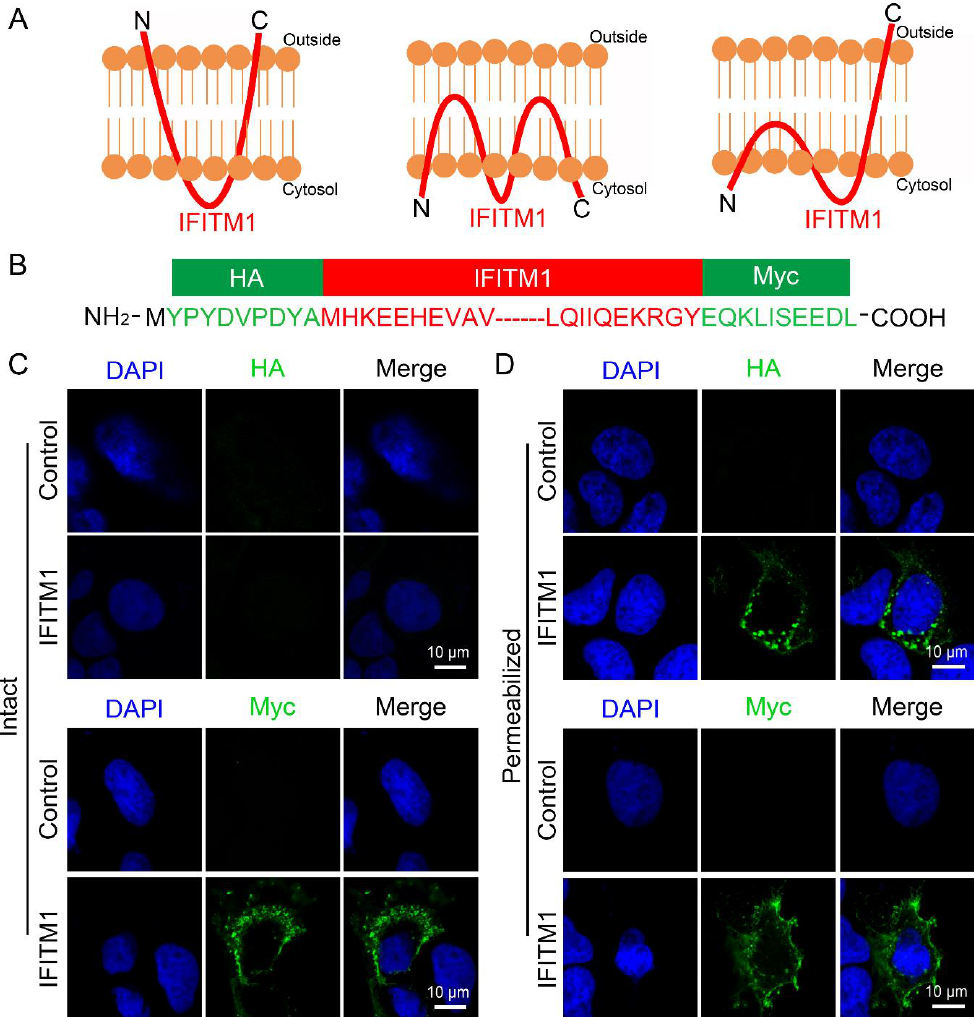
Figure 2. The topological structure analysis of IFITM1 on cell membranes. ( A ) Three different topological models of IFITM1 in cell membranes. IFITM1 was drawn using the red curve. N and C represented N-terminus and C-terminus, respectively. ( B ) Sketch of the amino acid sequence of HA-IFITM1-Myc. ( C , D ) The location of HA-IFITM1-Myc in Huh7 cells. pcDNA3.1 and pcDNA3.1-HA-IFITM1-Myc were transfected in Huh7 cells, respectively. After 24 h, cells were treated without 0.2% Triton X-100 ( C ) or with 0.2% Triton X-100 ( D ). Then, cells were stained with anti-HA antibody or anti-Myc antibody and DAPI. Cells were observed using confocal microscopy. HA-IFITM1-Myc, green. DAPI,